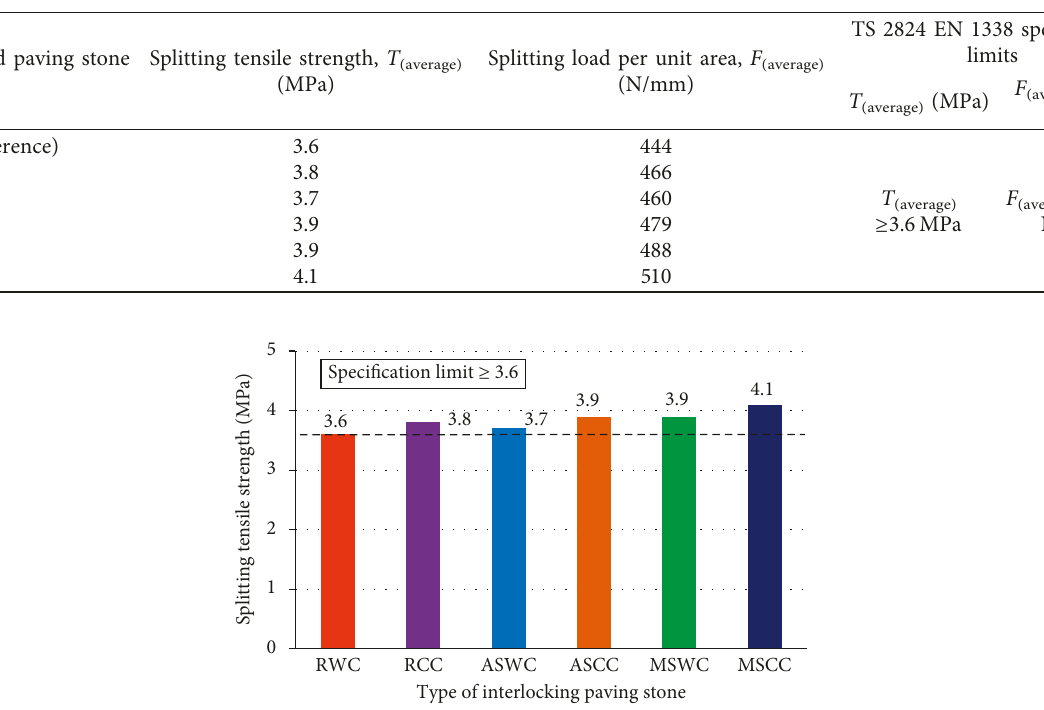
Figure 9: Specimen samples for the splitting tensile strength test. (a) Test device. (b) Broken samples. (c) Length of breakage. Table 18: Results of the splitting tensile strength test.